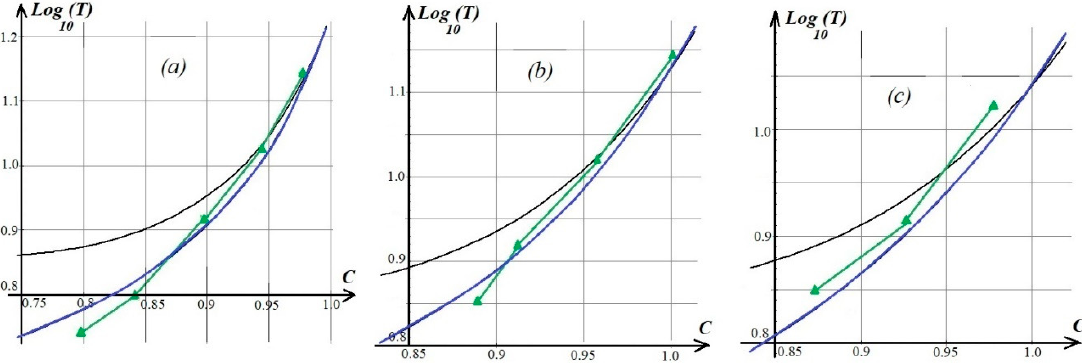
Figure 6. Dependence of the period of waves T on phase velocity C for various wave heights: ( a ) H = 0.15, ( b ) H = 0.25 and ( c ) H = 0.4; BM model—black lines, FN model—blue lines and experiments—green lines.